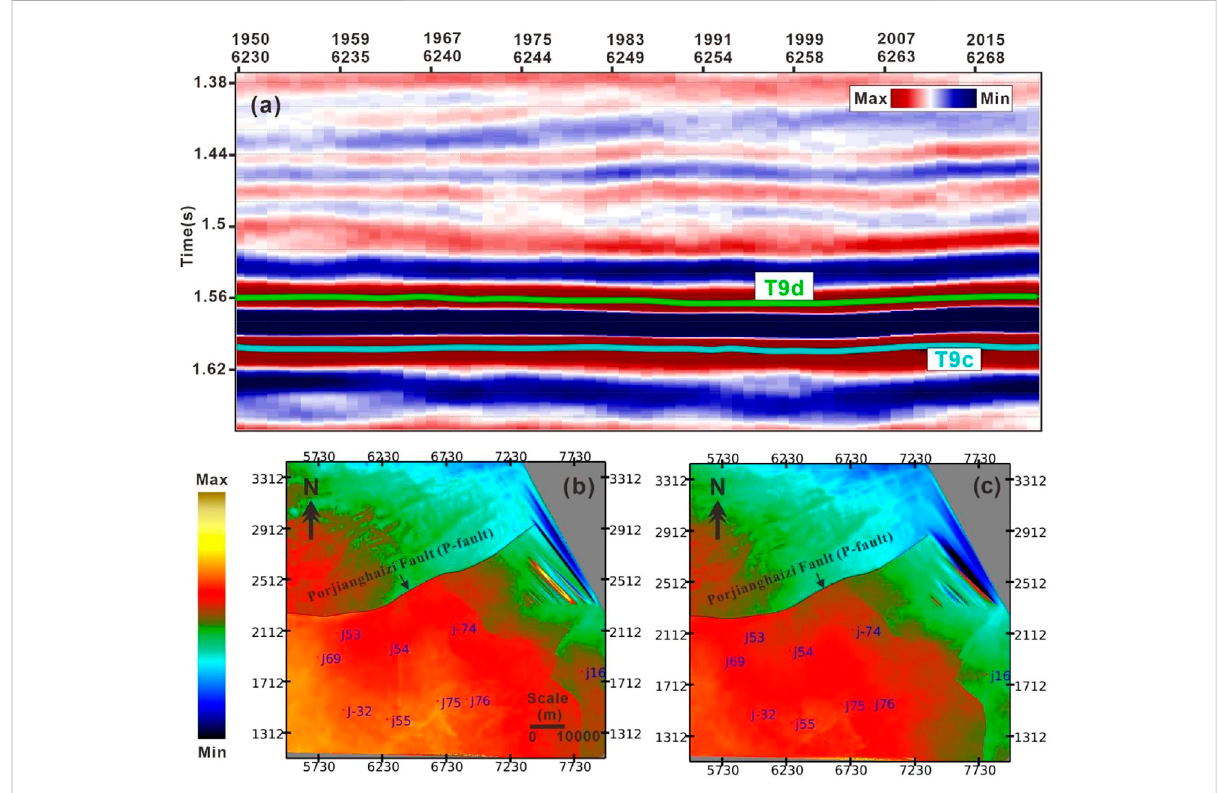
FIGURE 4 (A) Interpreted horizons T9c and T9d on the seismic section. Interpolations of horizons (B) T9c, and (C)